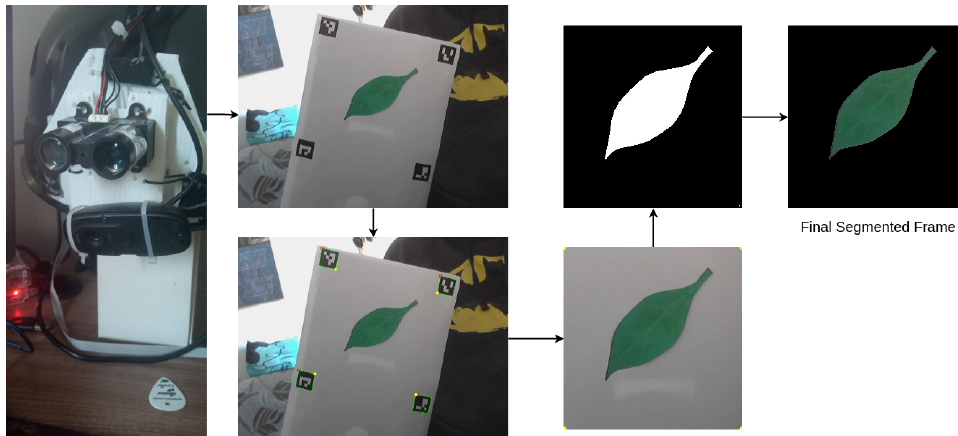
Figure 14. Sampling process illustration.